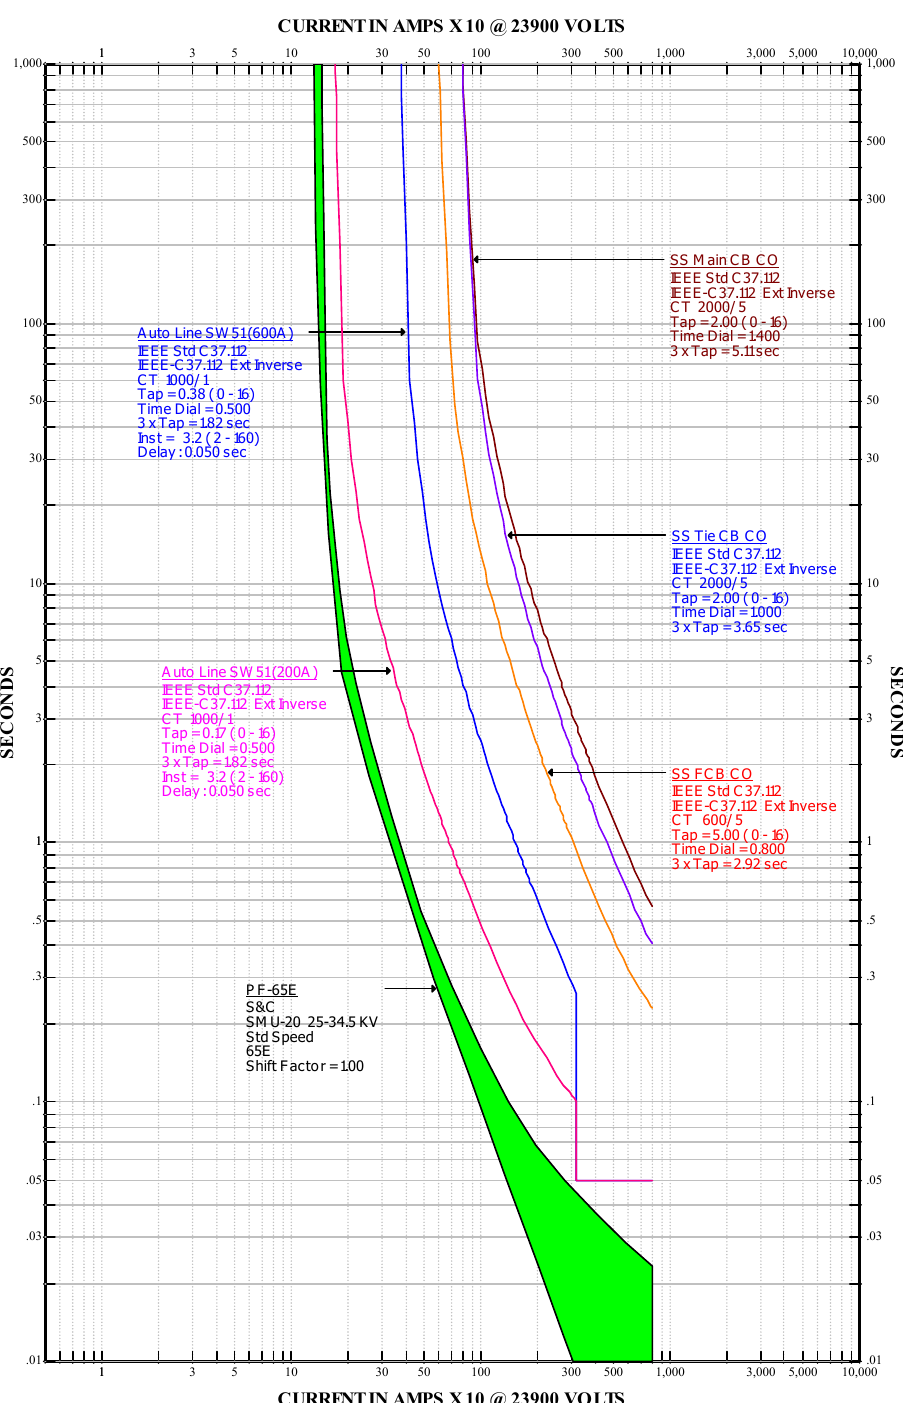
Figure 12. Proposed CO relays of Fuyuan